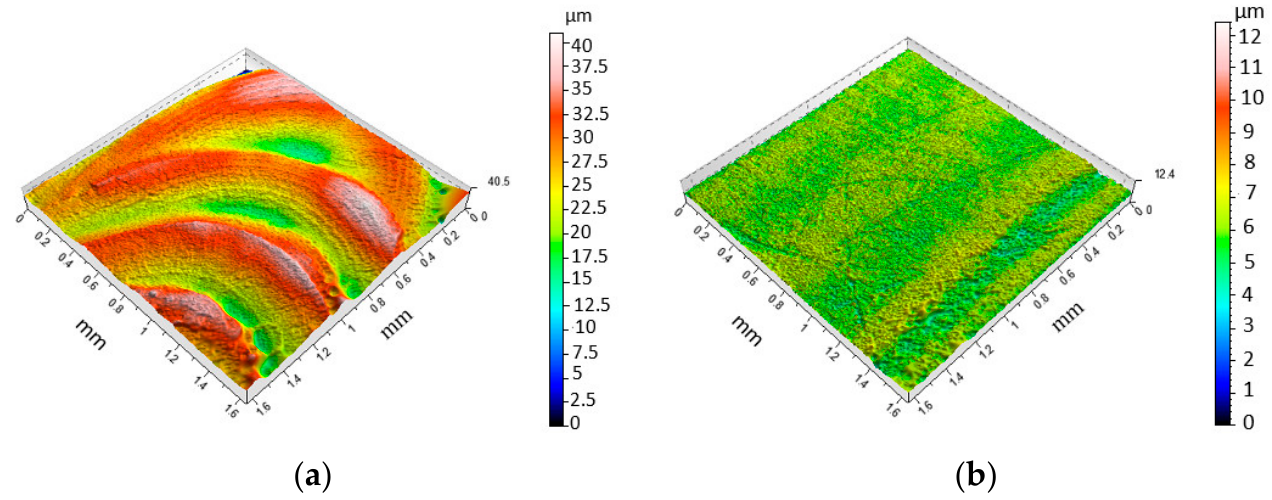
Figure 4. Three-dimensional roughness topography for variant 10 (specimen after TIG welding) in the ( a ) FZ and ( b ) BM.